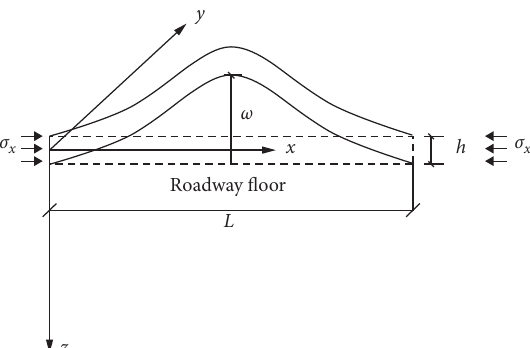
Figure 3: Schematic diagram of roadway floor stress